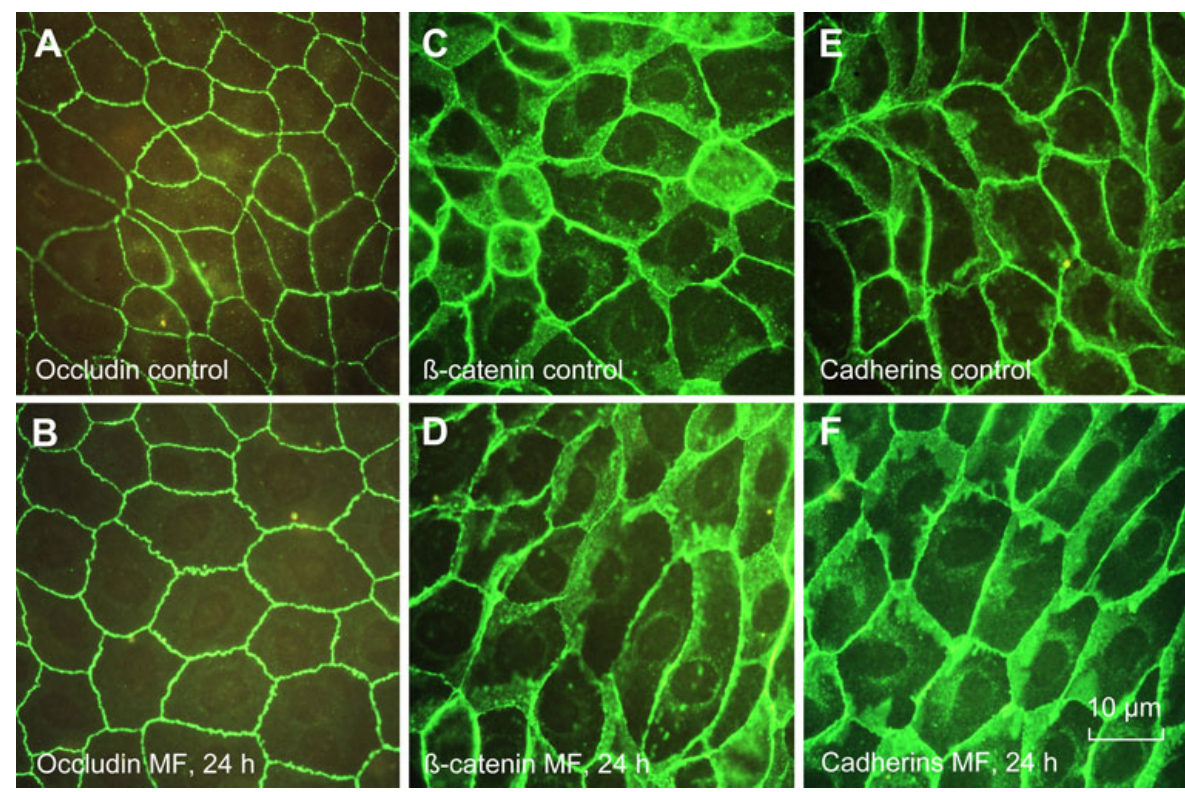
FIGURE 1 . Cellular distribution of occludin (A), β -catenin (C), and cadherins (E) in control and in MF-exposed (50 Hz, 24 h) (B, D, and E) MDCK